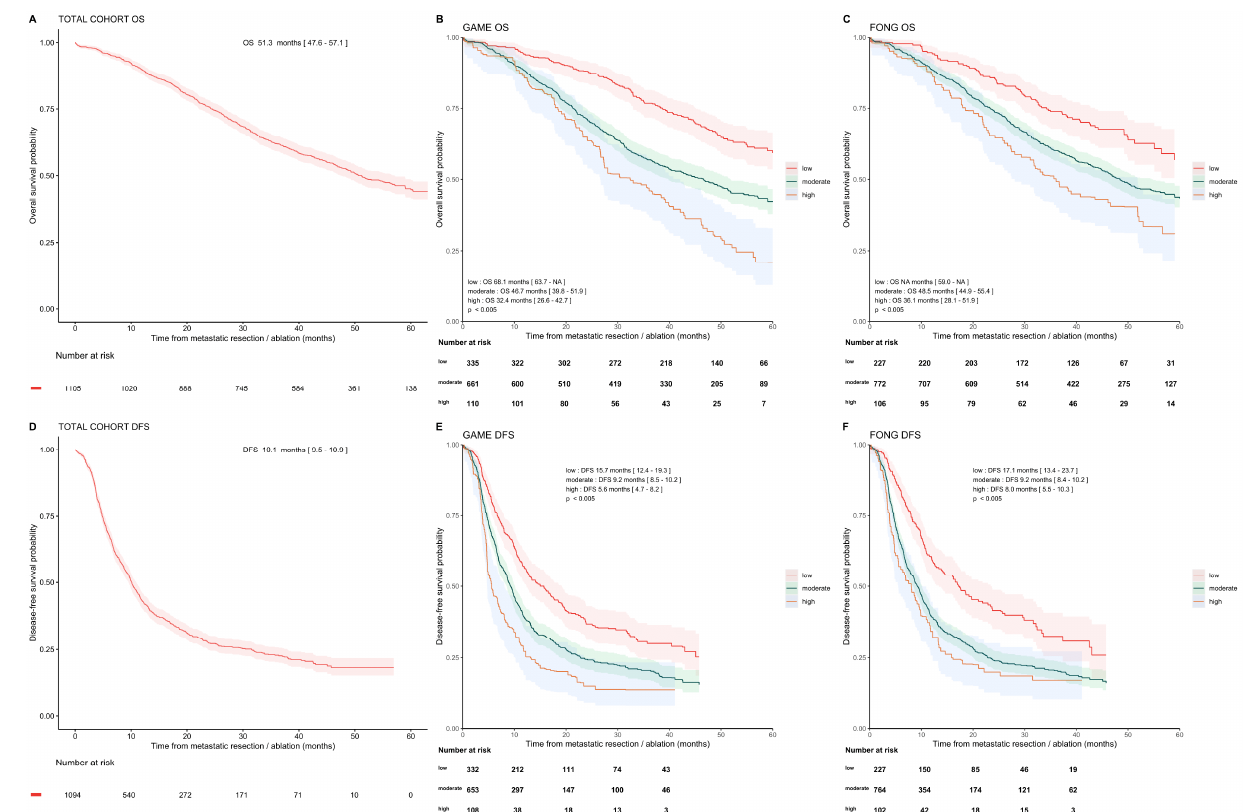
Figure 2. Overall survival and disease-free survival in cohort and subgroups . Kaplan–Meier analy- sis showing OS and DFS curves and 95% confidence intervals of the total cohort and for the risk categories following the GAME and Fong scores. OS for total cohort ( A ), and OS for GAME CRS risk groups ( B ), OS for Fong CRS risk groups ( C ). DFS for total cohort ( D ), DFS for GAME CRS risk categories ( E ), and DFS for Fong CRS risk categories ( F ).